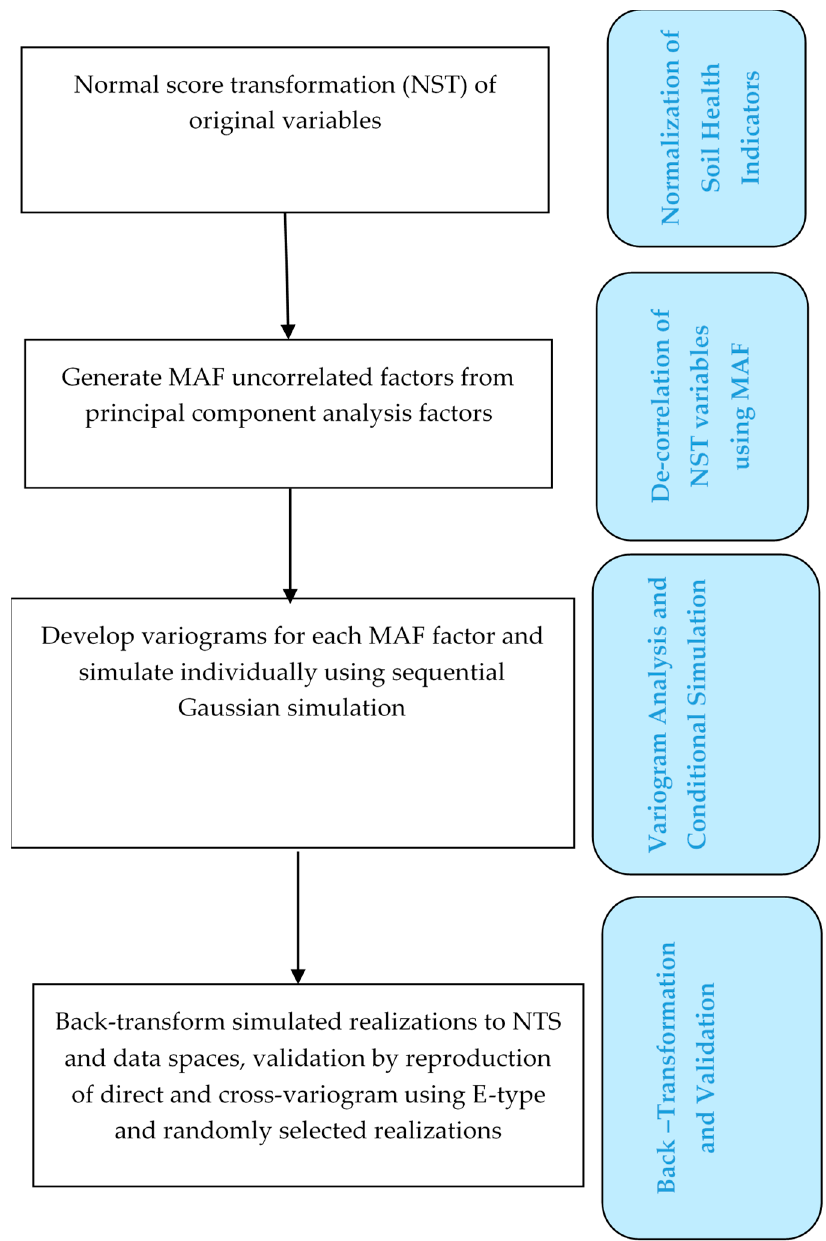
Figure 5. Workflow of minimum and maximum factors (MAF) and simulations.